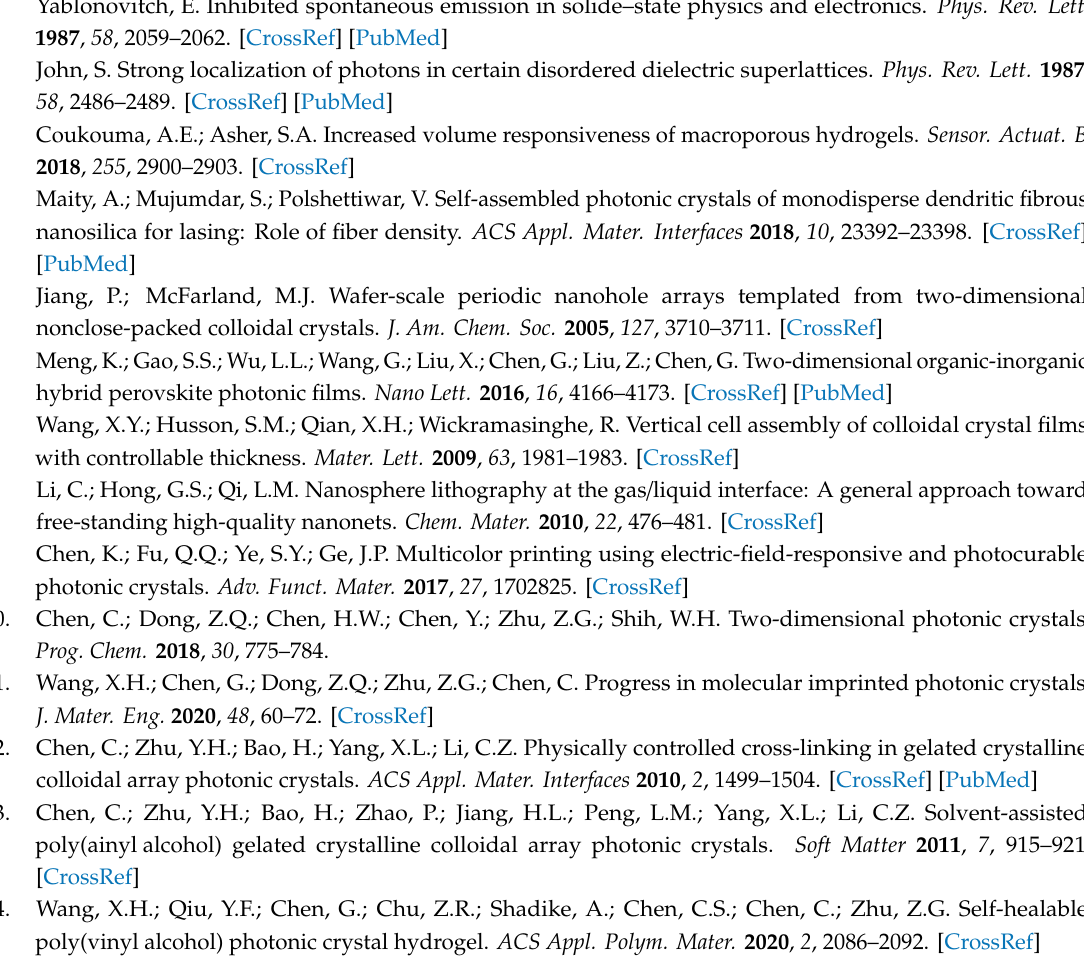
Figure S1: Schematic representation of the motion of PMMA colloids during self-assembling, Figure S2: Stacking comparison of CC with di ff erent thickness: upper is a 2-layer assembly of 200-nm PMMA and lower is a 52-layer assembly of 117-nm PMMA, Figure S3: Thickness ( T ) and layers ( L ) analysis of spray coated 117-nm PMMA CC, Figure S4: Time dependence of the PMMA crystal thickness during spray process, Figure S5: 200-nm PMMA crystal coated on the optical glasses using spray process; and Table S1: Calculated data according to Fabry–P é rot